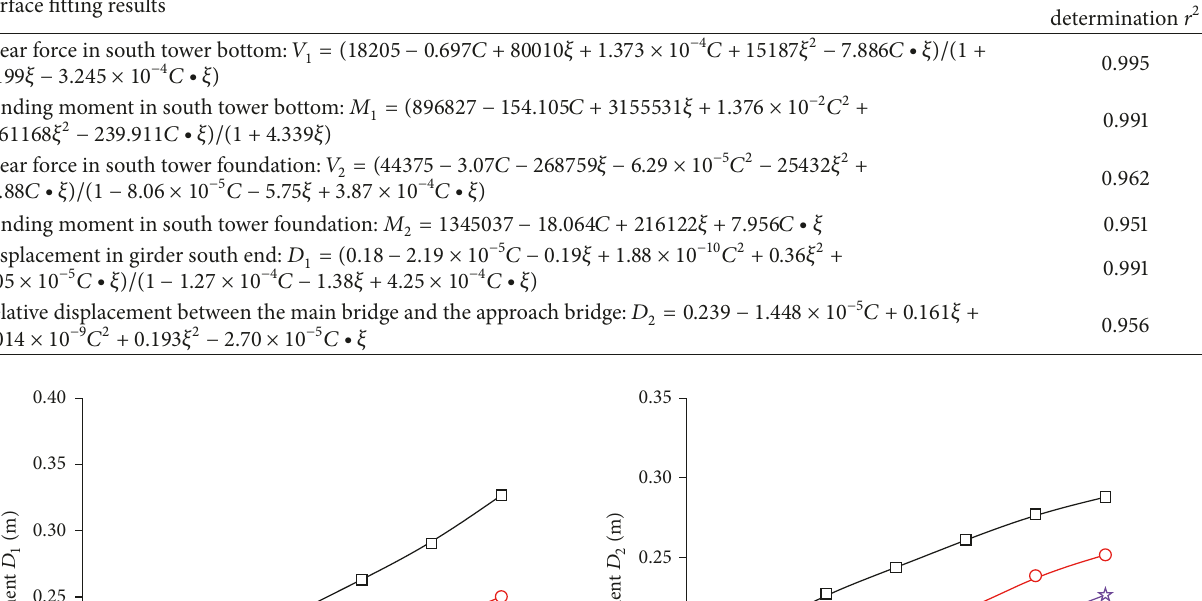
Surface fitting results